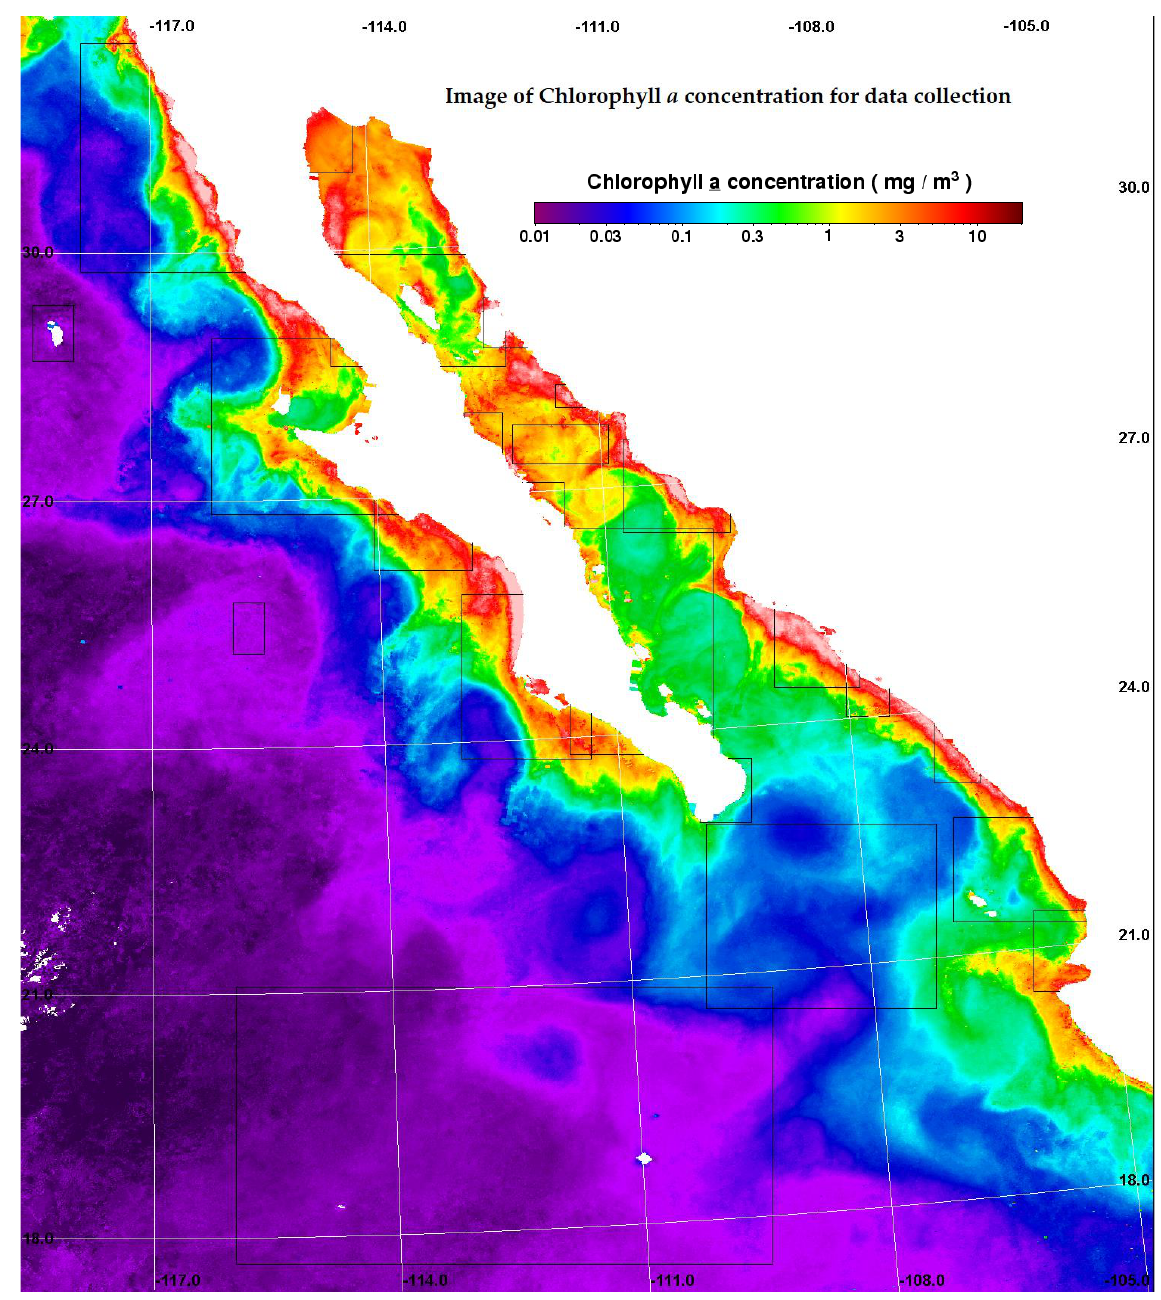
Figure 2. Satellite image the Chl a monthly mean data for the 24 PMR of the Northwest of Mexico. The black boxes indicate the regions from which the chlorophyll a concentration data was obtained. The image corresponds to April 2006.